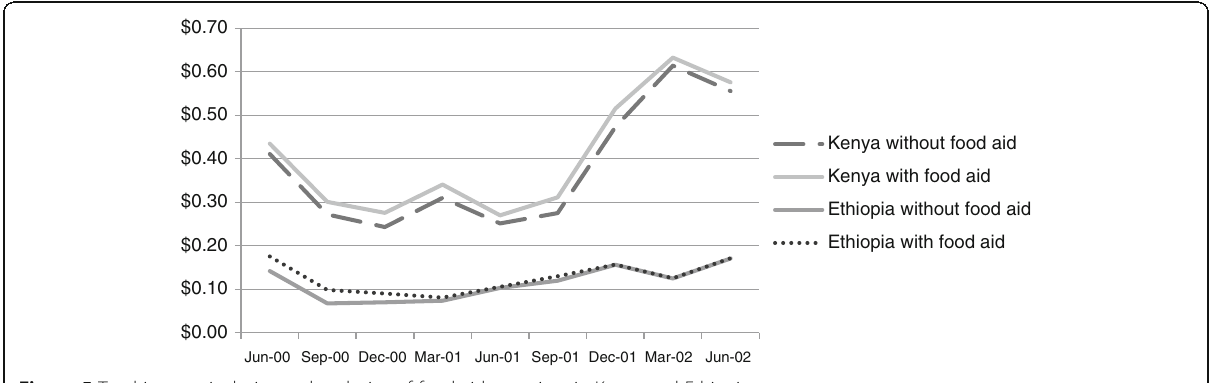
Figure 5 Total income inclusive and exclusive of food aid over time in Kenya and Ethiopia